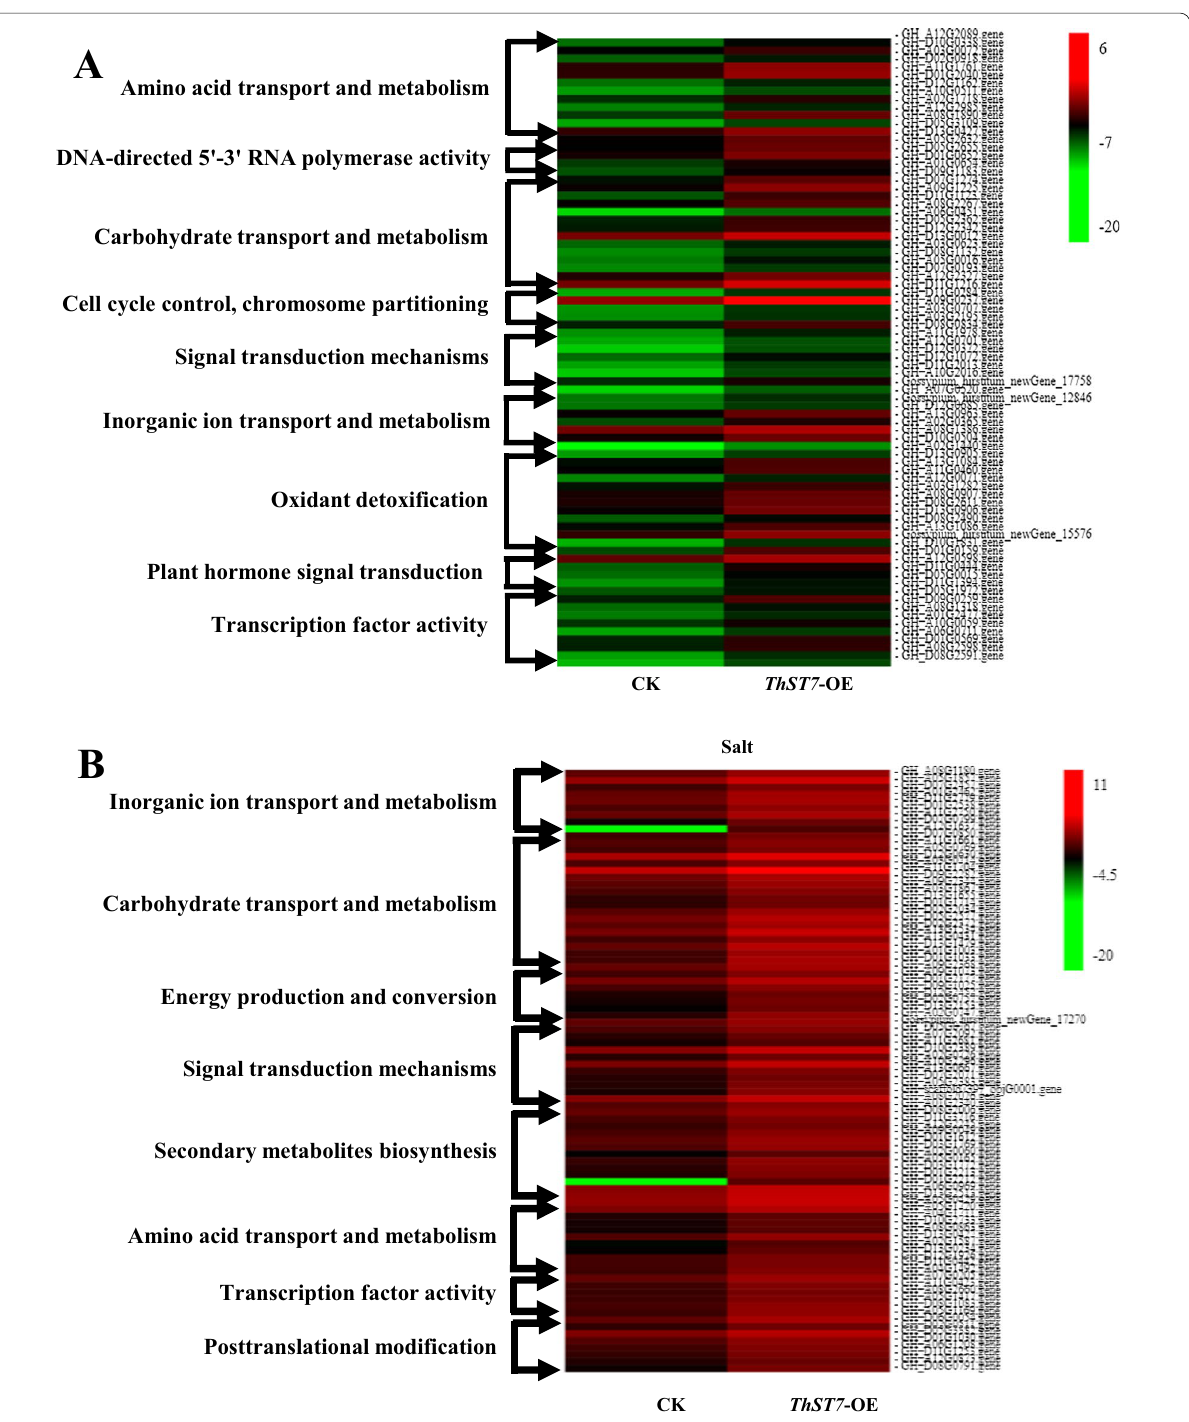
Fig. 7 Heatmap of genes upregulated by in ST7 -OE plants under normal conditions. Genes involved in different biological processes in CK and ST7 -OE plants under normal conditions ( A ) and salt stressed conditions ( B ) were shown. The results were presented as log(2) ratios. Only results with a P value < 0.05 and that have been confirmed in three independent experiments were included. A color code was used to visualize the